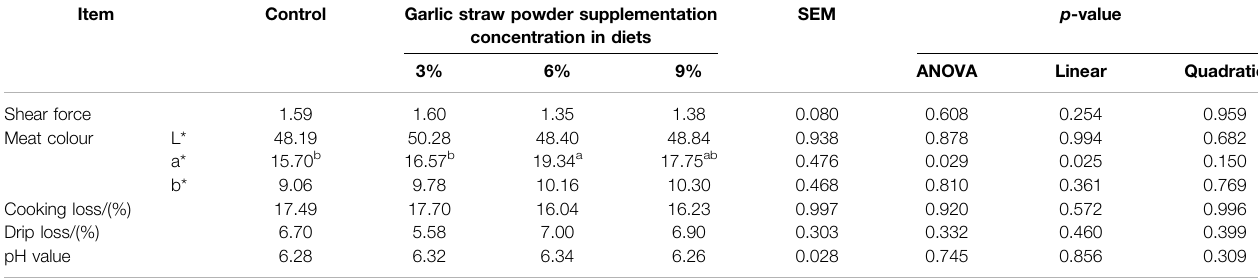
TABLE 4 | Effects of different dietary levels of garlic straw powder on leg muscle quality in yellow-feathered broilers (g). Item Control Garlic straw powder supplementation SEM p -value concentration in diets 3% ANOVA Linear Quadratic Shear force